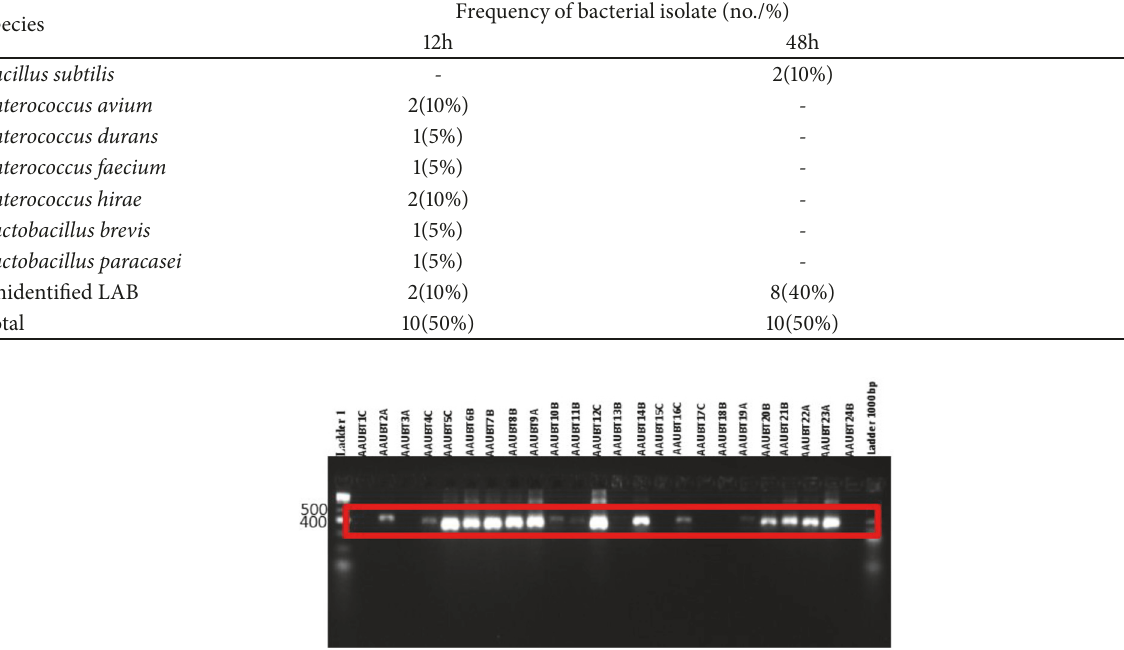
Table 2: Acid production capacity of the isolates after incubation.